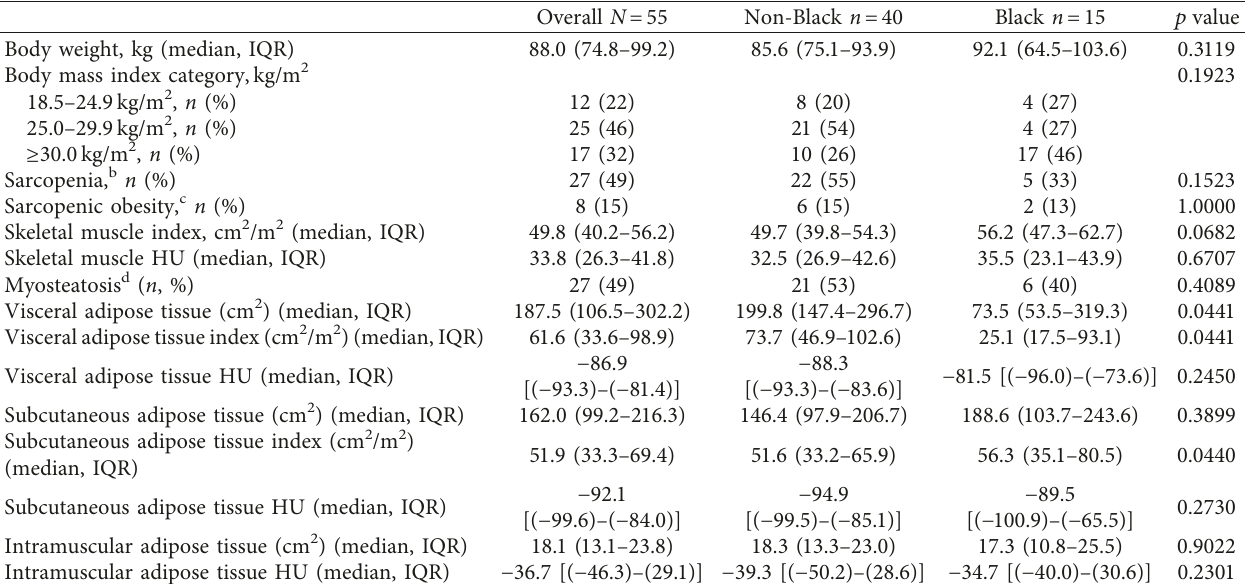
Table 2: Body composition characteristics in Black versus non-Black men with treatment na¨ıve hormone-sensitive metastatic prostate cancer a .